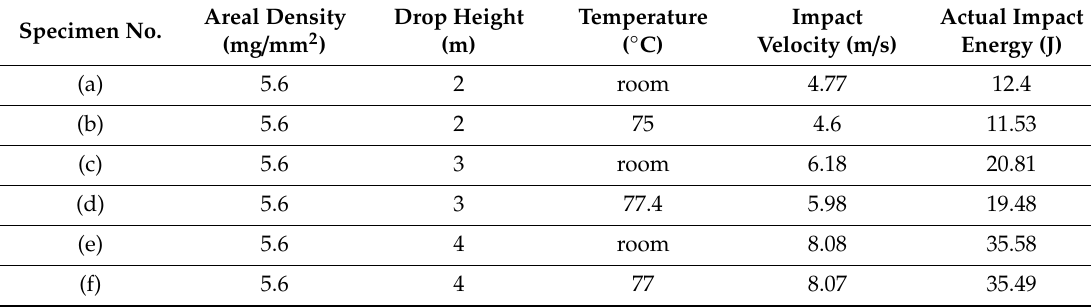
Table 5. Test matrix of low velocity impact on GLARE